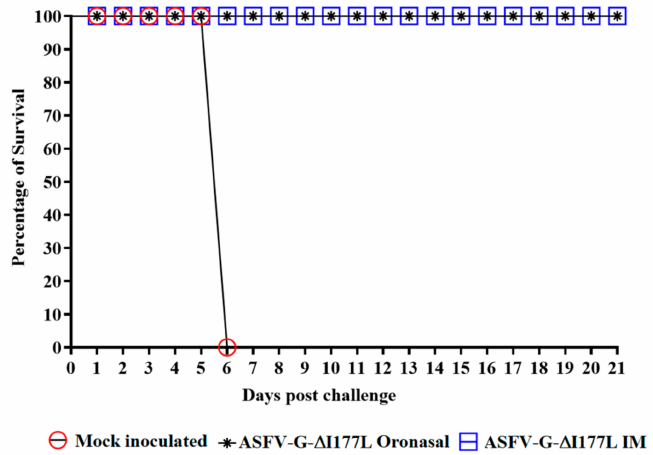
Figure 3. Evolution of mortality in pigs either oronasally or intramuscularly inoculated with ASFV- G- ∆ I177L or mock treated and challenged with 10 2 HAD 50 of ASFV-G. Viremia values from mock-inoculated animals infected with ASFV-G were as expected, with high titers (10 5 to 10 8.5 HAD 50 /mL) on day 4 pi, increasing (averaging HAD 50 /mL) until day 6 pi, when all animals were euthanized. Conversely, viremia values after challenge in animals intramuscularly inoculated with ASFV-G- ∆ I177L progressively decreased in the two animals with high titers at the time of challenge until the end of the experimental period (21 days after challenge), at which time no virus could be detected in one animal, and very low titers (10 3.5 HAD 50 /mL) were measured in the other (Figure 2). Two of the three animals with undetectable viremia at challenge remained with undetectable titers until the end of the experiment (21 days post challenge - dpc) (Figure 2), while another animal experienced intermittent viremia peaks after challenge with undetectable titers by 21 dpc. After challenge, the group of animals oronasally inoculated with ASFV-G- ∆ I177L presented low viremia titers ( ≤ 10 2.8 HAD 50 /mL) throughout the 21-day observational period or had undetectable viremias on the final day of the experiment (Figure 2). These results indicate that both IM and ON administration of ASFV-G- ∆ I177L effec- tively induces protection against challenge with the virulent parental